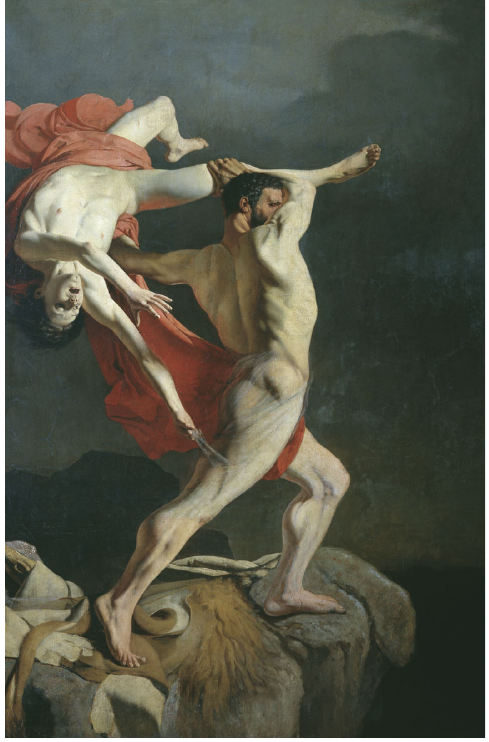
Figure 14. Pavel Sorokin. Hercules and Lichas , 1849. Odesa National Fine Arts Museum.